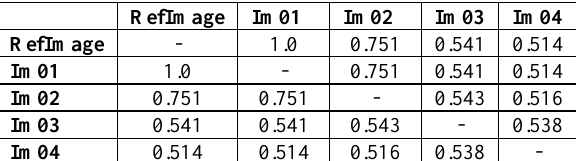
Table 2 . SSIM indexes resulting from the comparison of three images to a reference